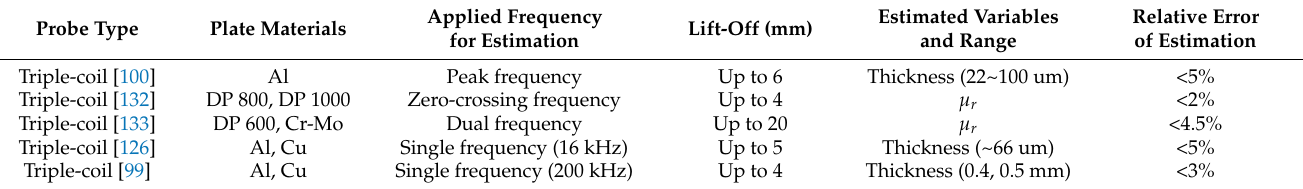
Table 7. Experimental evaluation results of representative probes for lift-off